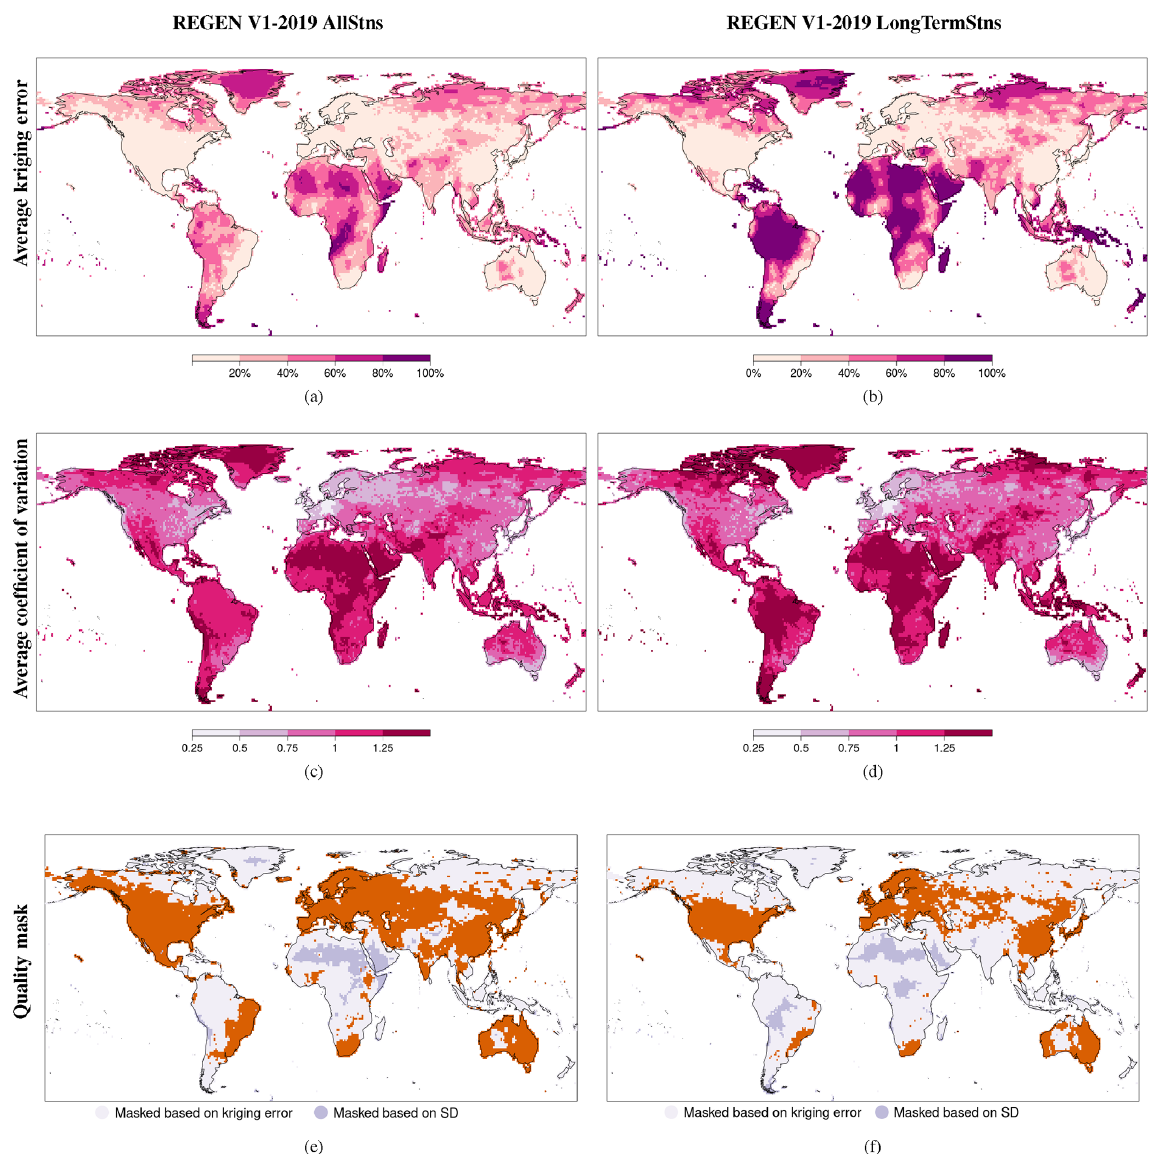
Figure 5. Kriging error (KE) (a, b) and coefficient of variation (CoV) (c, d) defined by the ratio of the Yamamoto standard deviation (Yamamoto, 2000) averaged over 1950–2016 and the daily precipitation averaged over 1950–2016, and masks based on the KE and CoV (e, f) based on REGEN (a, c, e) and REGEN40YR (b, d, f) data. SD: standard